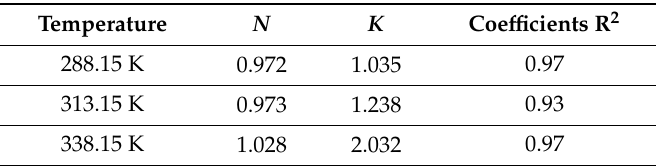
Table 2. Values of constants n and K of Freudlich isotherms for